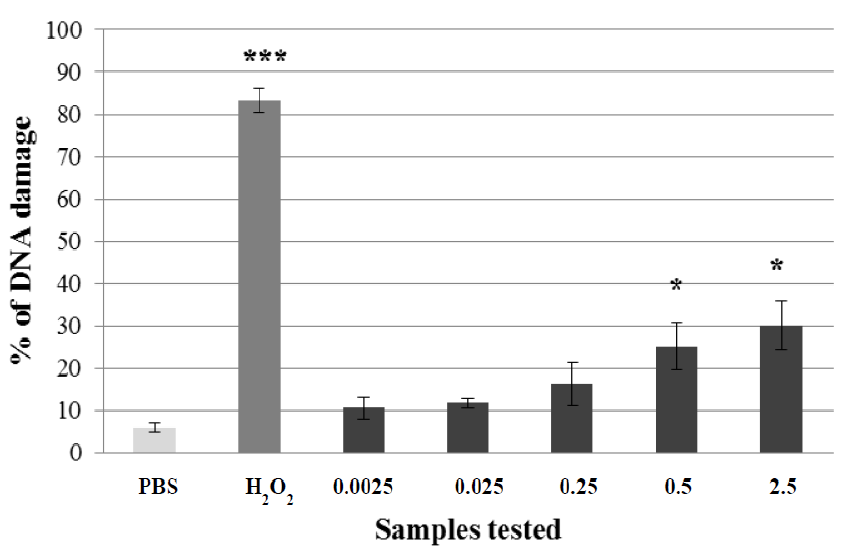
Figure 3. Potential genotoxic activity of different concentrations of kaempferol ( A ) and quercetin ( B ) tested on lymphocytes using the comet assay. Legend for the x axis: 0 = PBS, O = positive control, 5–100 = samples treated with flavonoid DMSO = solvent, H 2 2 (concentration in μ g·mL − 1 ). All experiments were performed at least three times.